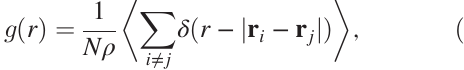
TABLE I. Fraction of C points with different line classification. The results of our 2D experiment are compared with previous experiments [27] and theory [26].